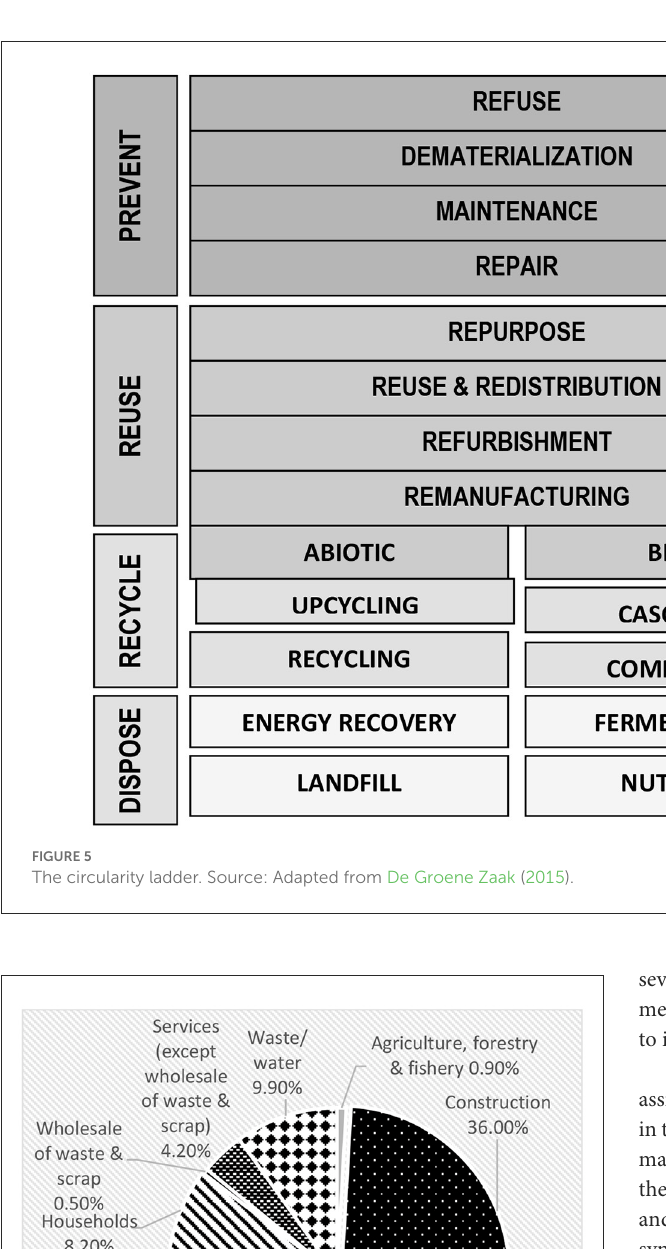
(2018) described the criteria weights as expressing the significance and influence on the evaluation results. These criteria weights can be subjective, objective, and integrated based on classifications